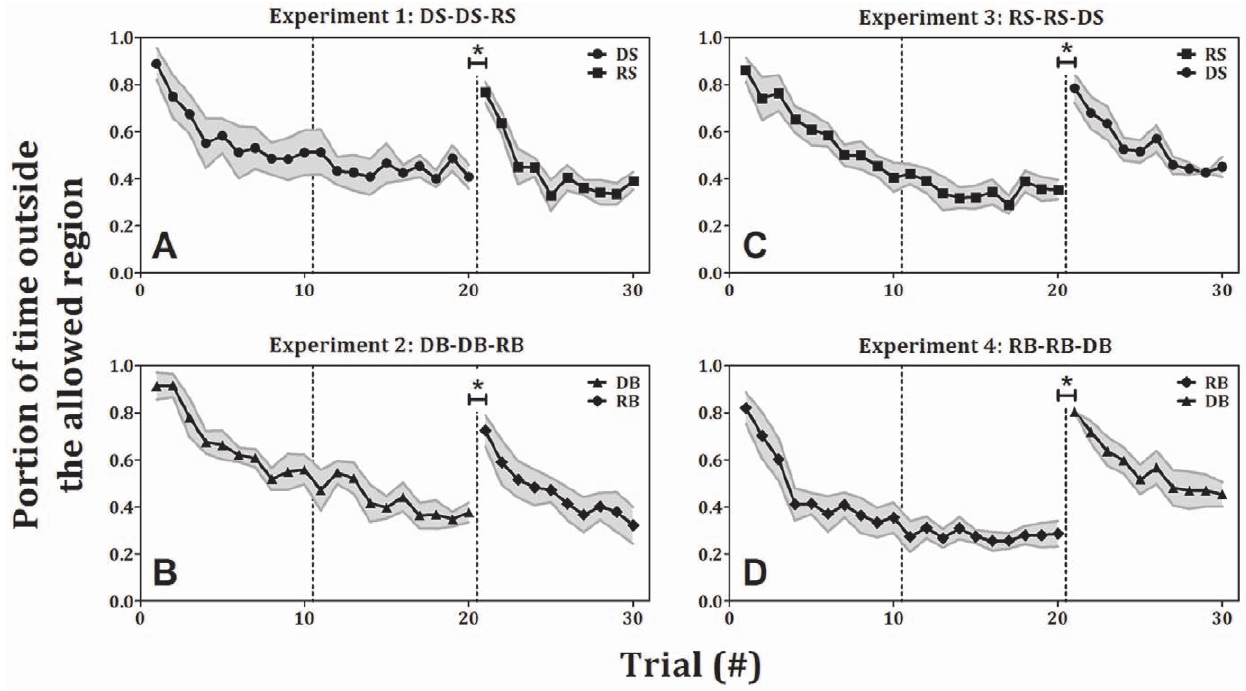
Figure 5. Error as a function of trial number for experiments 1–4 ( ± standard error). Each shape represents a different condition of the task: circles – discrete small, triangles – discrete big, rectangles – rhythmic small, diamonds – rhythmic big. In all transitions, from discrete movements to rhythmic ones (panels A and B) and from rhythmic movements to discrete ones (panels C and D), there was a significant increase in error.